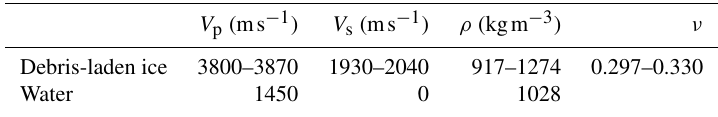
Table 2. Range of seismic properties assumed for the lower ice shelf. ν denotes Poisson’s ratio.